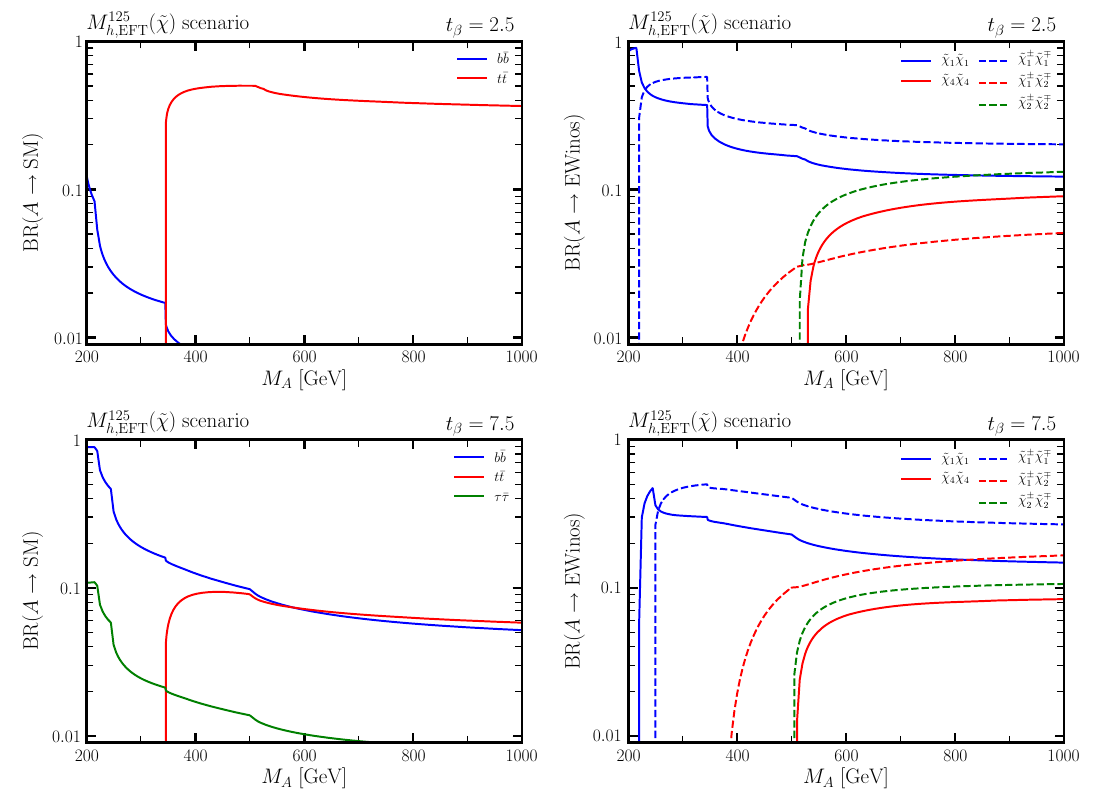
( ˜ χ) scenario as a function of M β = 2 . 5 A , for fixed tan h , EFT